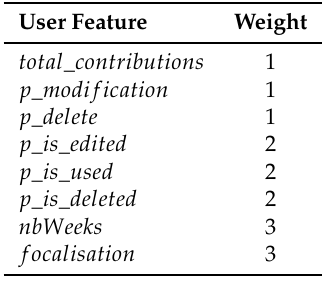
Table 2. User feature weights for weighted _ avg .